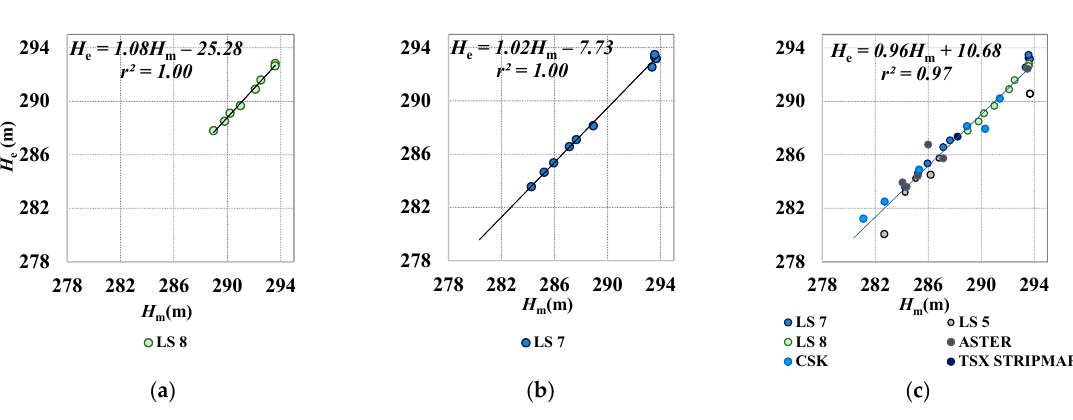
Figure 11. Water levels measured in situ ( H m ) vs. levels evaluated trough classification ( H e ) using: ( a ) LS8; ( b ) LS7; ( c ) all data.